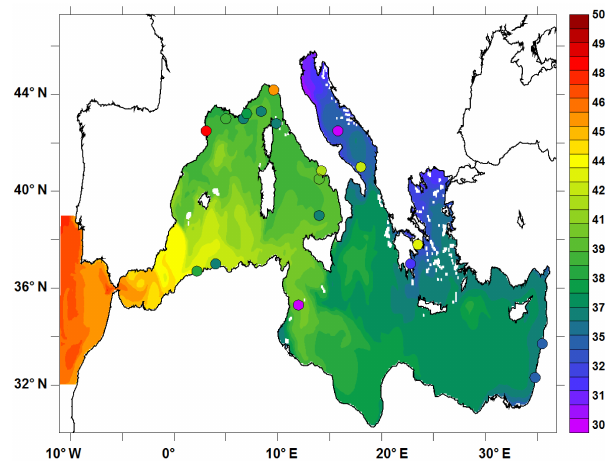
Figure 3. Average radiocarbon age (years) in the upper 50m as computed with the model for 1940. Circles represent reser- voir ages derived from measurements of the composition of shells (Siani et al., 2000; Reimer and McCormac, 2002) and from corals (Tisnérat-Laborde et al.,